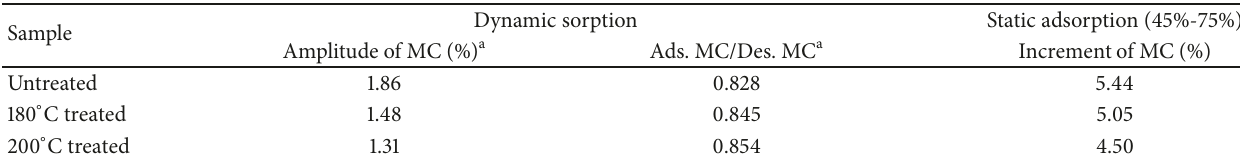
Table 3: Amplitude of MC response and hysteresis ratio of all the samples under dynamic conditions and MC increment from RH 45% to 75%.